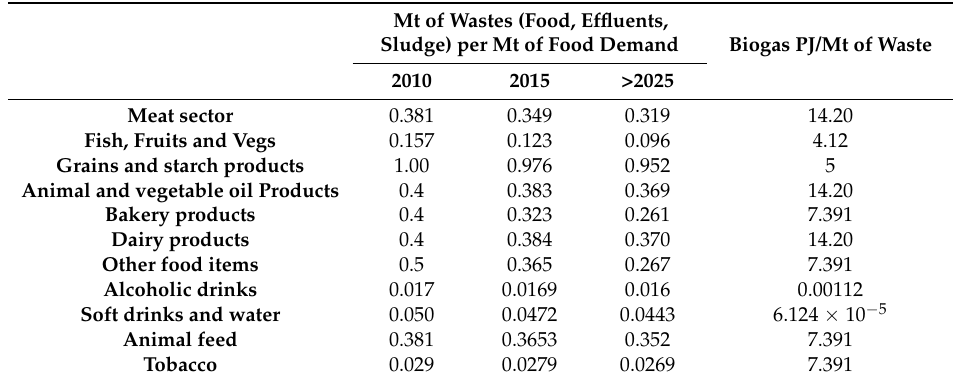
Table 3. Amount of Waste generated by the sector and respective biogas